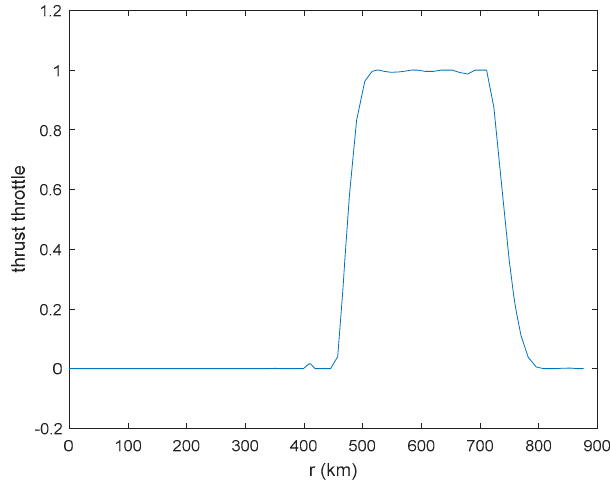
Figure 5. Optimal thrust throttle at the initial altitude of 45 km